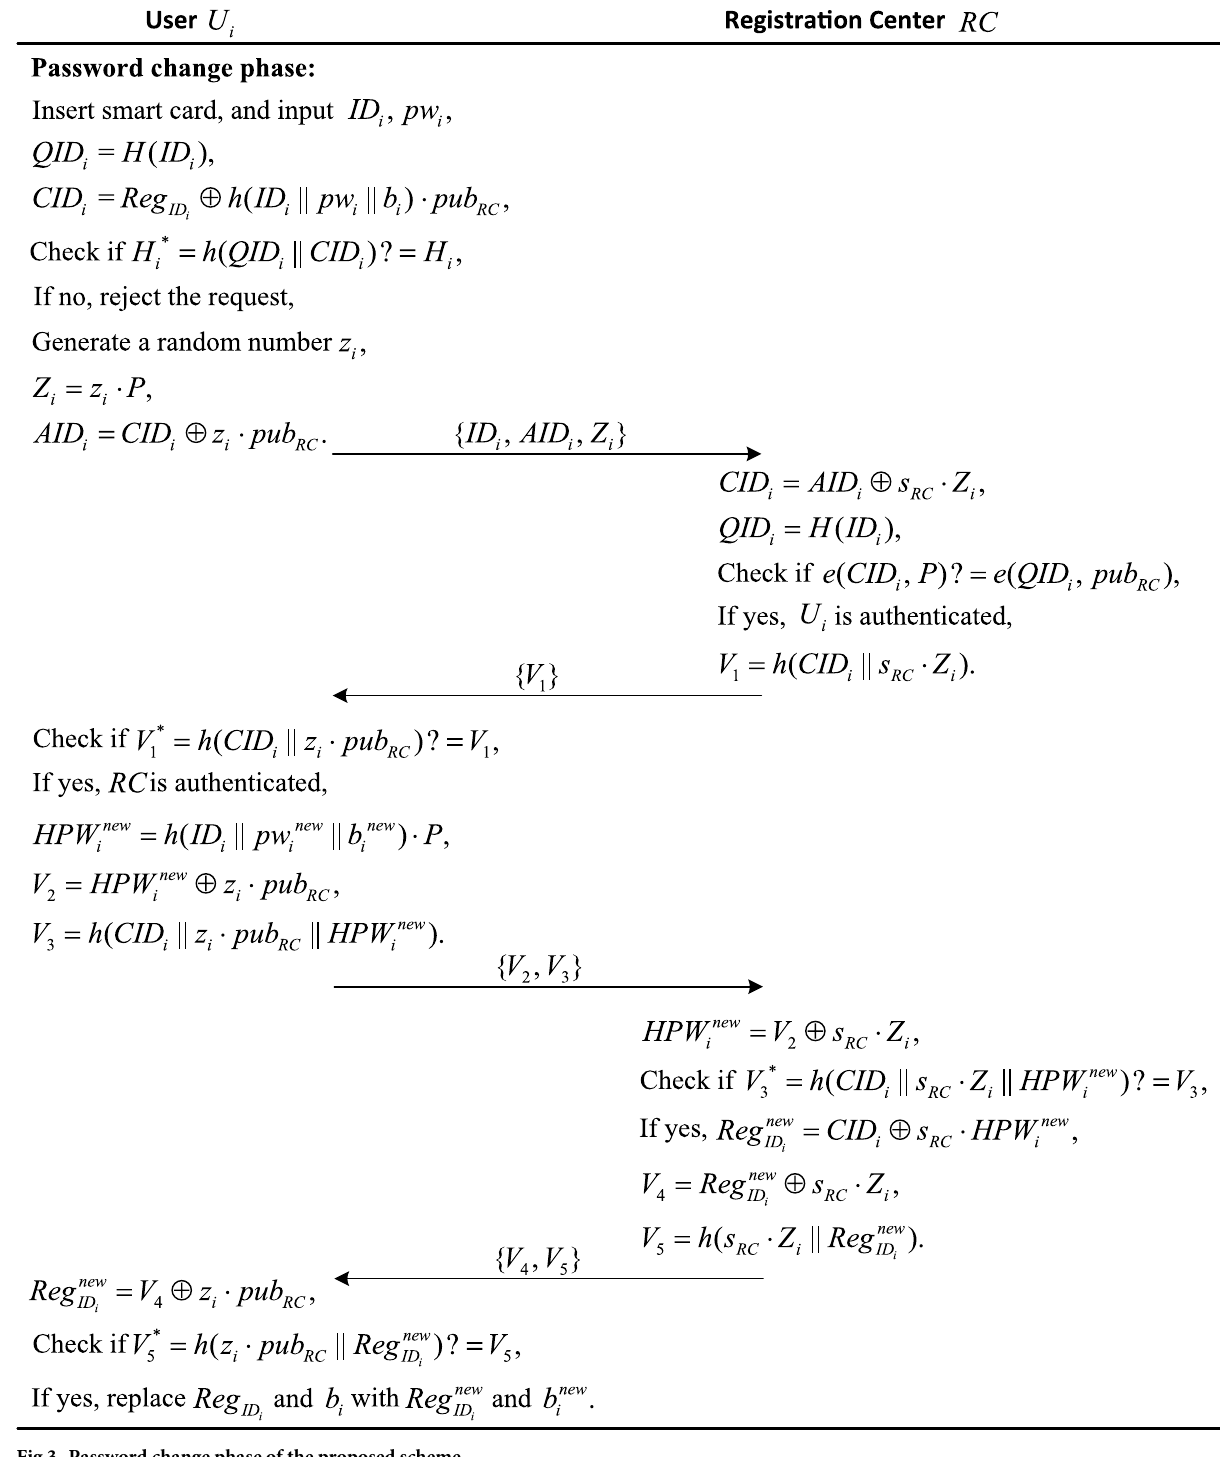
Fig 3. Password change phase of the proposed